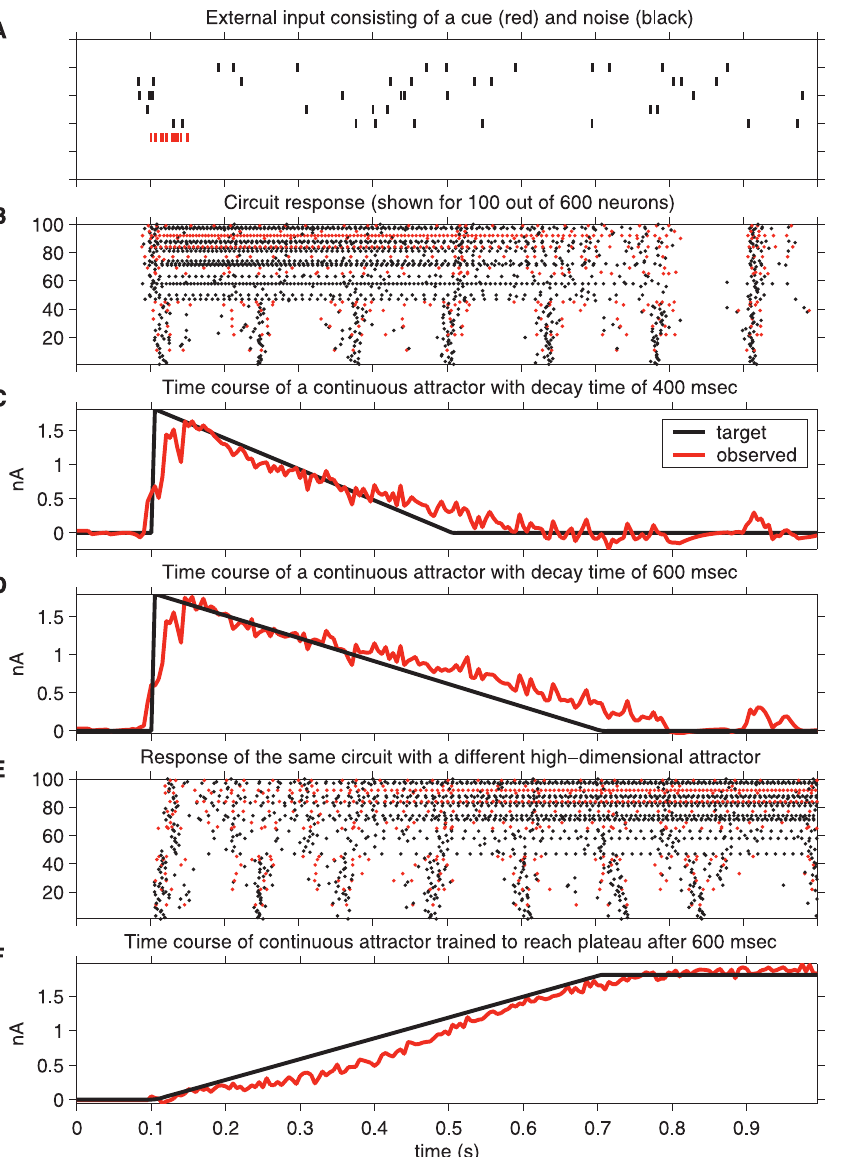
Figure 3. Representation of Time for Behaviorally Relevant Timespans in a Generic Cortical Microcircuit Model (A) Afferent circuit input, consisting of a cue in one channel (red) and random spikes (freshly drawn for each trial) in the other channels. (B) Response of 100 neurons from the same circuit as in Figure 2, which has here two coexisting high-dimensional attractors. The autonomously generated periodic bursts with a periodic frequency of about 8 Hz are not related to the task, and readouts were trained to become invariant to them. (C,D) Feedback from two linear readouts that were simultaneously trained to create and control two high-dimensional attractors. One of them was trained to decay in 400 ms (C), and the other in 600 ms (D) (scale in nA is the average current injected by feedback into a randomly chosen subset of neurons in the circuit). (E) Response of the same neurons as in (B), for the same circuit input, but with feedback from a different linear readout that was trained to create a high-dimensional attractor that increases its activity and reaches a plateau of 600 ms after the occurrence of the cue in the input stream. (F) Feedback from the linear readout that creates this continuous high-dimensional attractor.